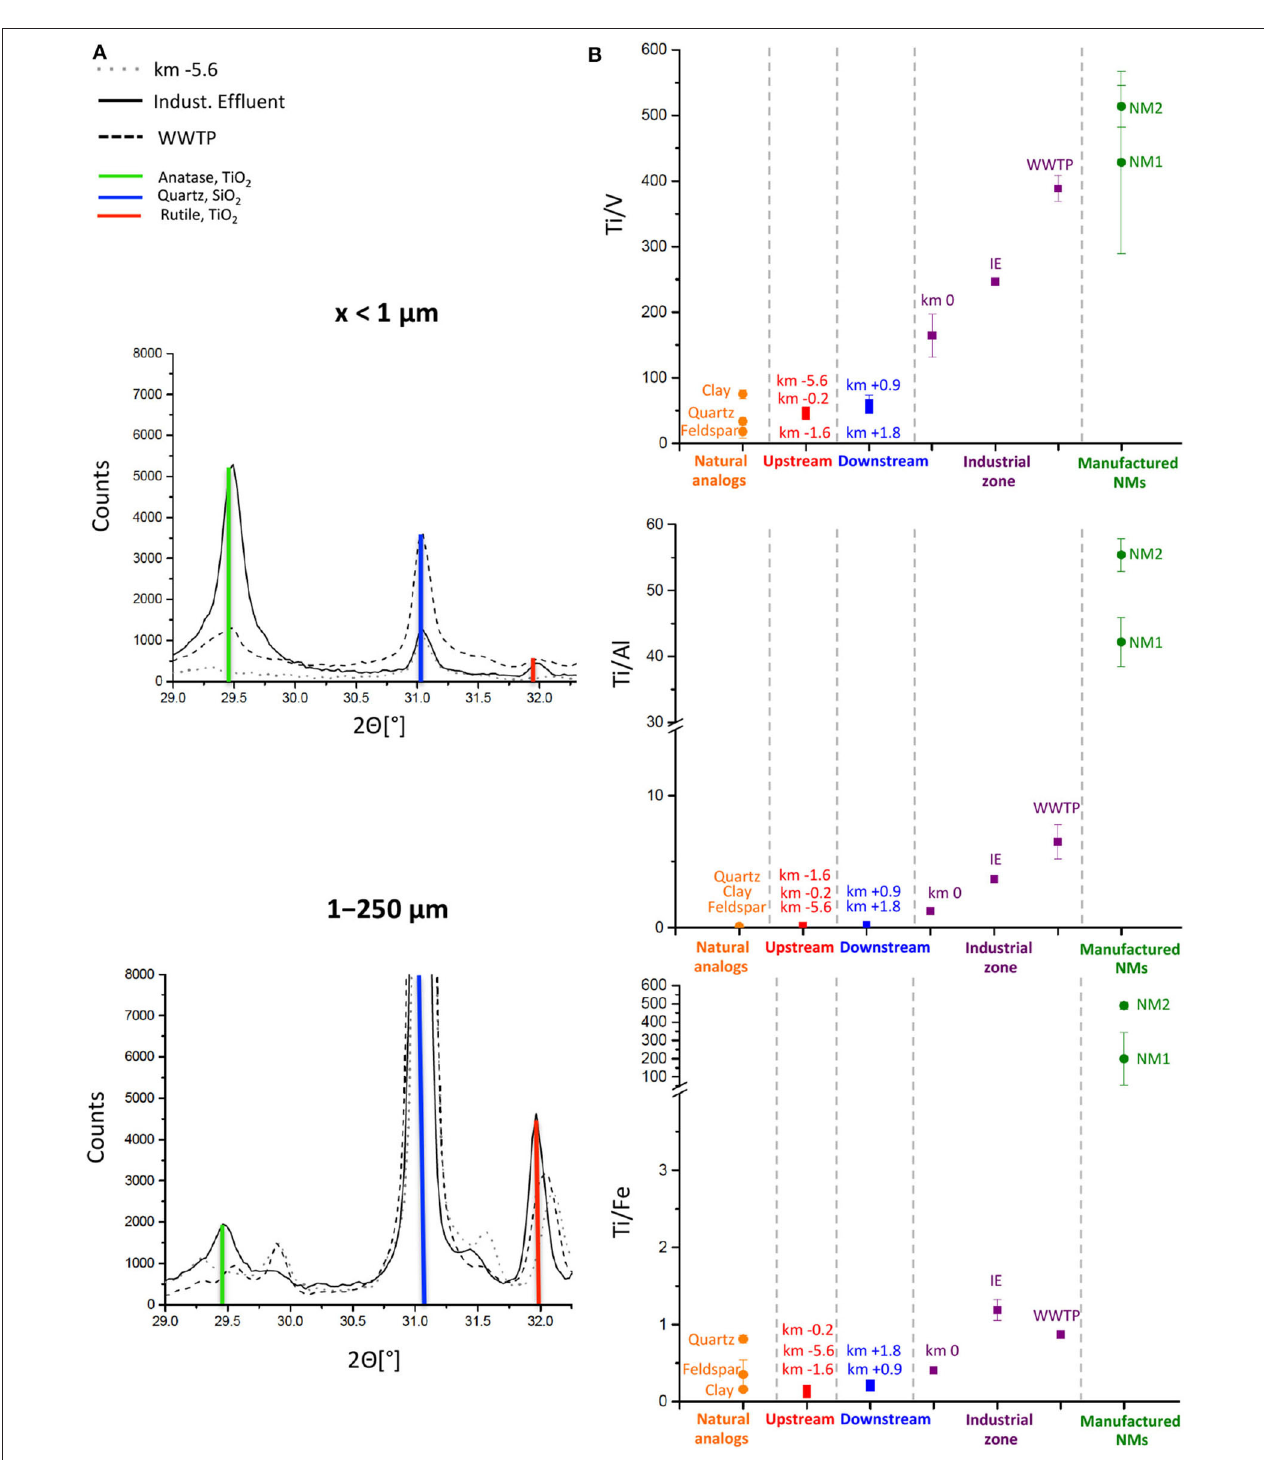
FIGURE 3 | Mineralogical and elemental analysis of sediments from October 2017: (A) XRD of fine fraction (x < 1 µ m) and 1–250 µ m fraction validating presence of anatase and rutile TiO 2 in Industrial Effluent and WWTP (Full XRD spectra in Supporting Information Figure S3 ). (B) Ratios of Ti/X (X = V, Al, and Fe) concentrations of analogs (e.g., NM1, NM2, clay) and river sediment to differentiate between anthropogenic inputs and natural TiO 2 . IE, Industrial Effluent. Error bars represent replicate sample digestions of the same sample ( n =